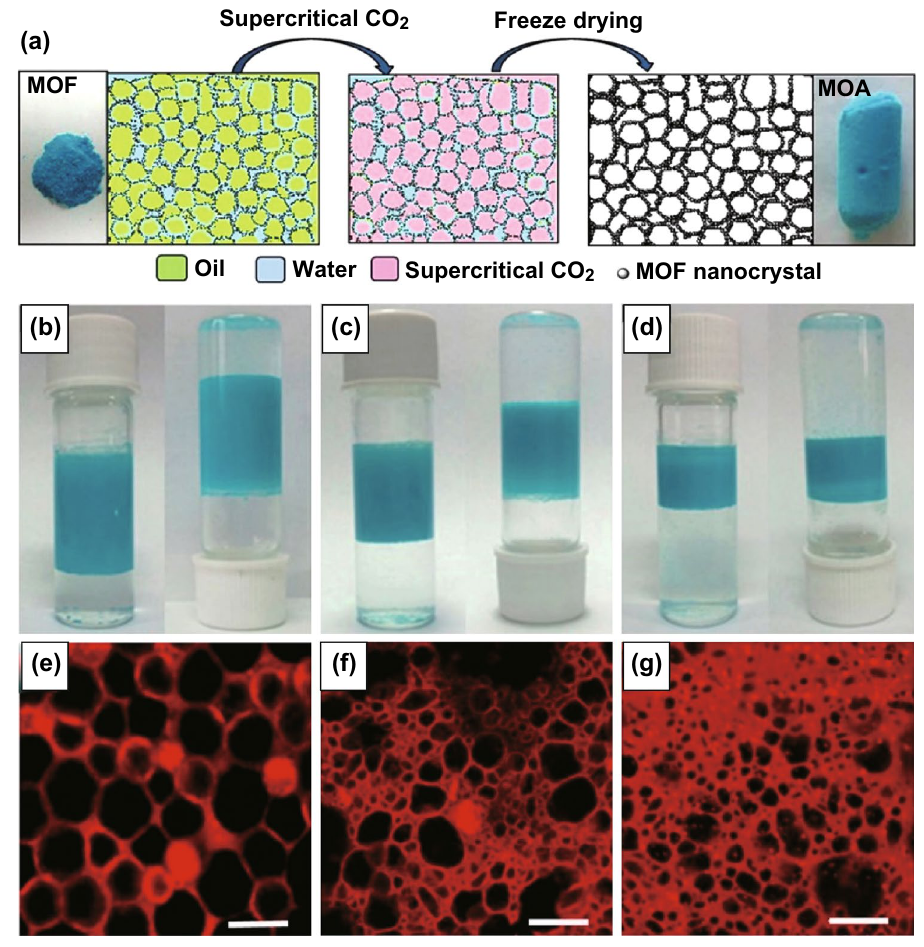
Fig. 14 a Diagram illustrating the MOF-stabilised HIPE and derivation of MOA from HIPE. b–d Photographs of the emulsions stabilised by Cu 3 (BTC) 2 with the initial diethyl ether volume fractions of 0.57, 0.43, and 0.29, respectively, demonstrating ability to tune pore size in HIPEs. e – g The corresponding confocal laser scanning microscopy images of the above HIPEs (HIPE-1, HIPE-2, and HIPE-3, respectively). Scale bars, 20 µm. Reprinted with permission from Zhang et al. [109]. Copyright CC BY-NC-SA